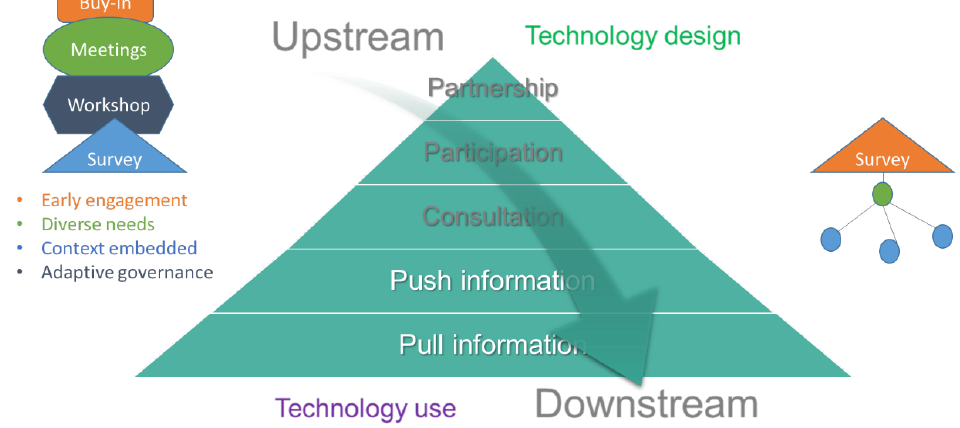
Figure 2. Stakeholder engagement conceptual model expressed in two parts. Overlaying upstream engagement in technology design with a model of stakeholder engagement [41,55], and the process followed for implementing the data collection and co-design framework (including buy-in, meetings, workshop and survey).